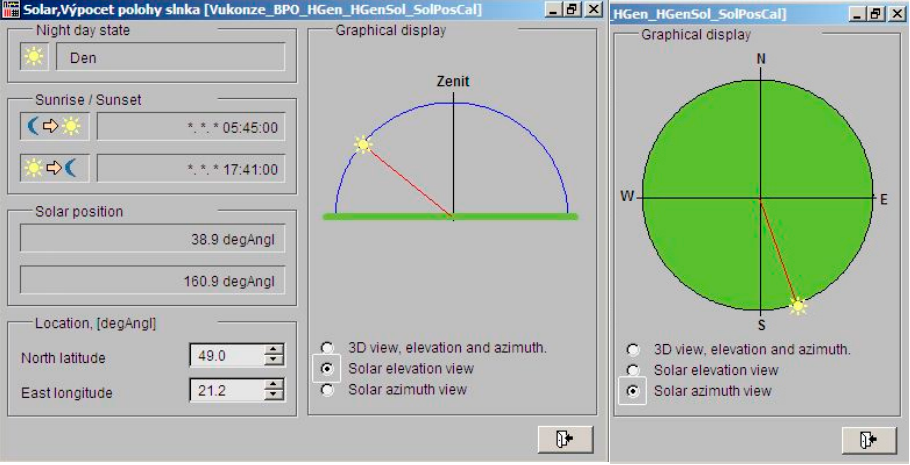
Figure 6. Position control system.